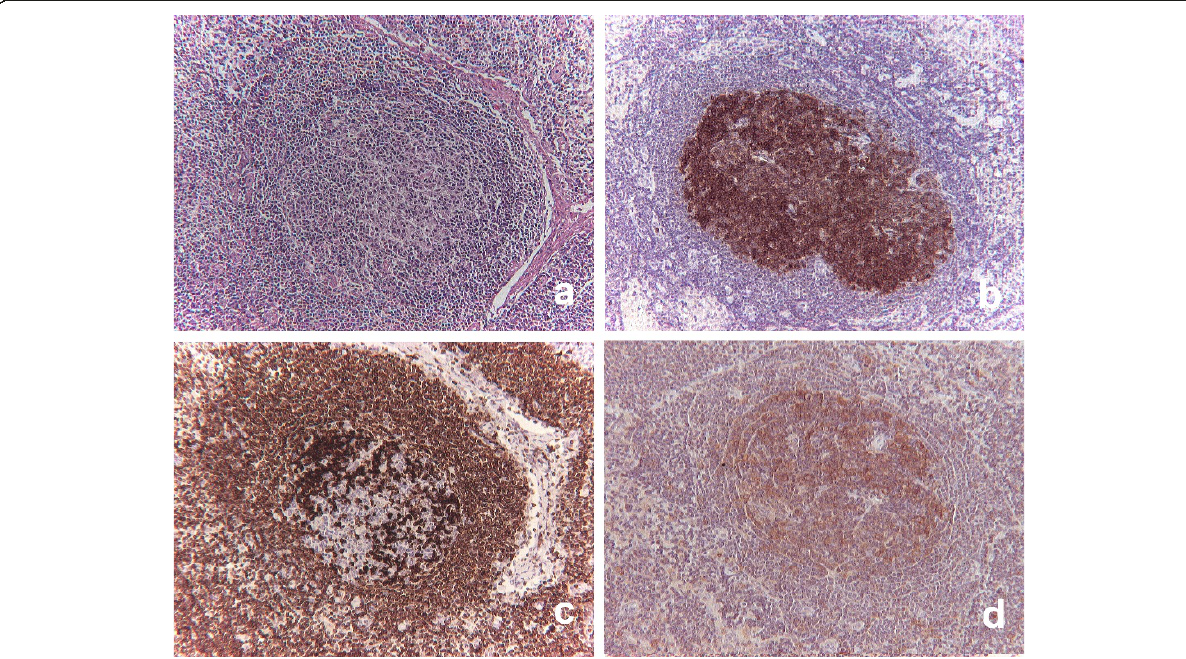
Figure 1 “ In situ ” follicular neoplasm . The follicle depicted in serial sections shows partial polarization loss and prevalence of small cells (a), all staining for CD10 (b), strongly for BCL2 (c) and for HGAL